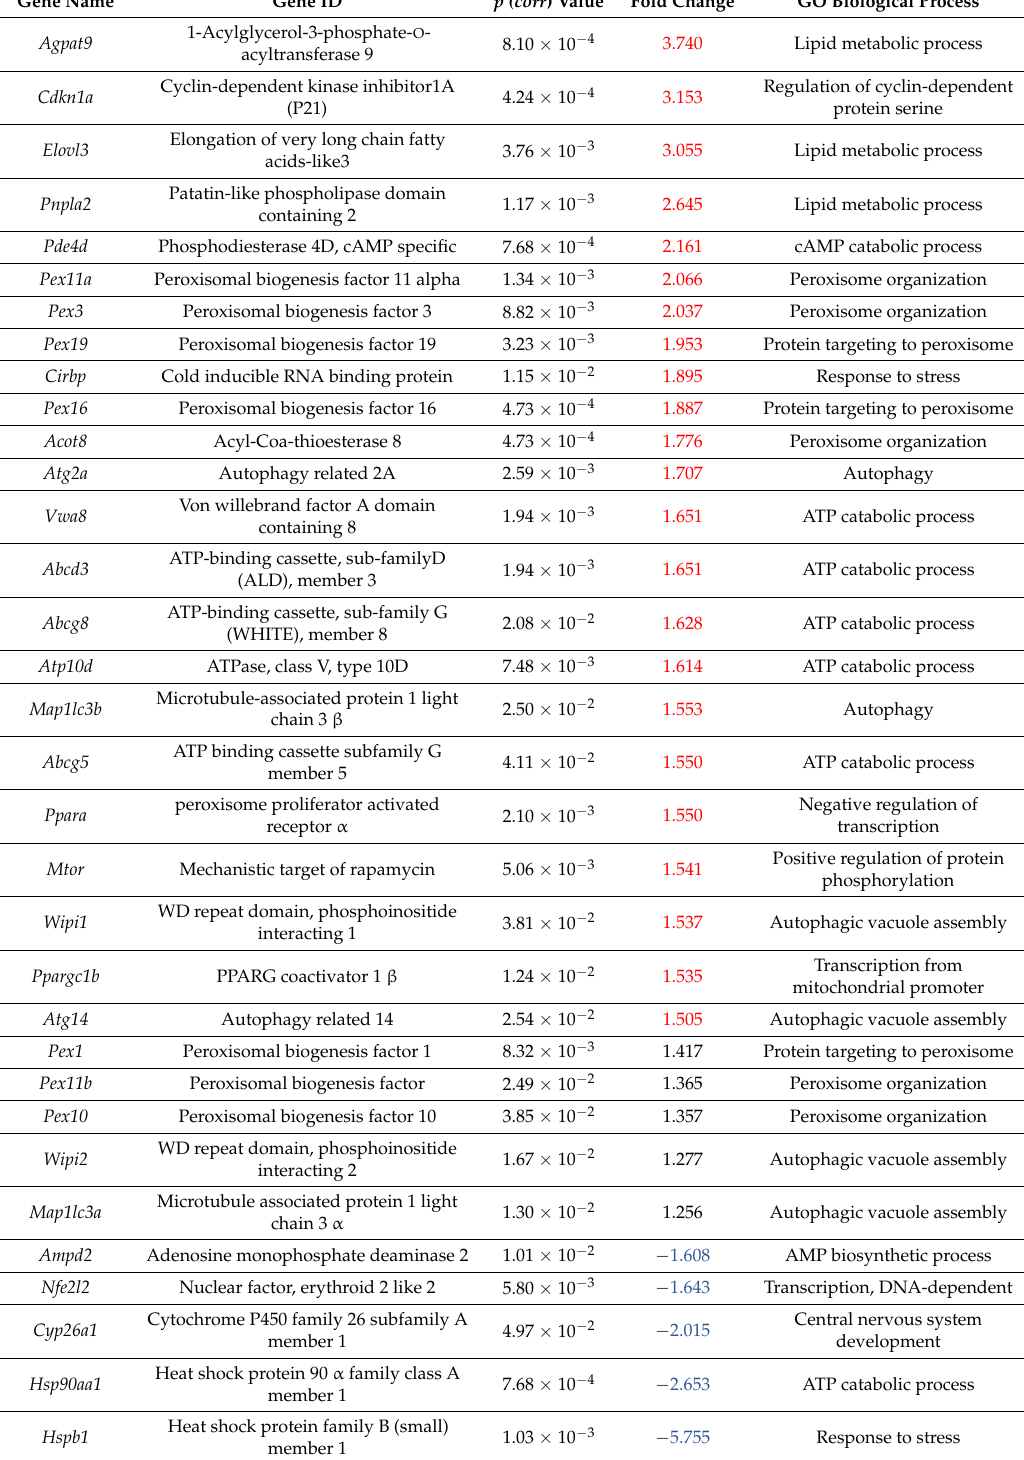
Table 3. Differentially regulated genes and biological processes in livers of FLT